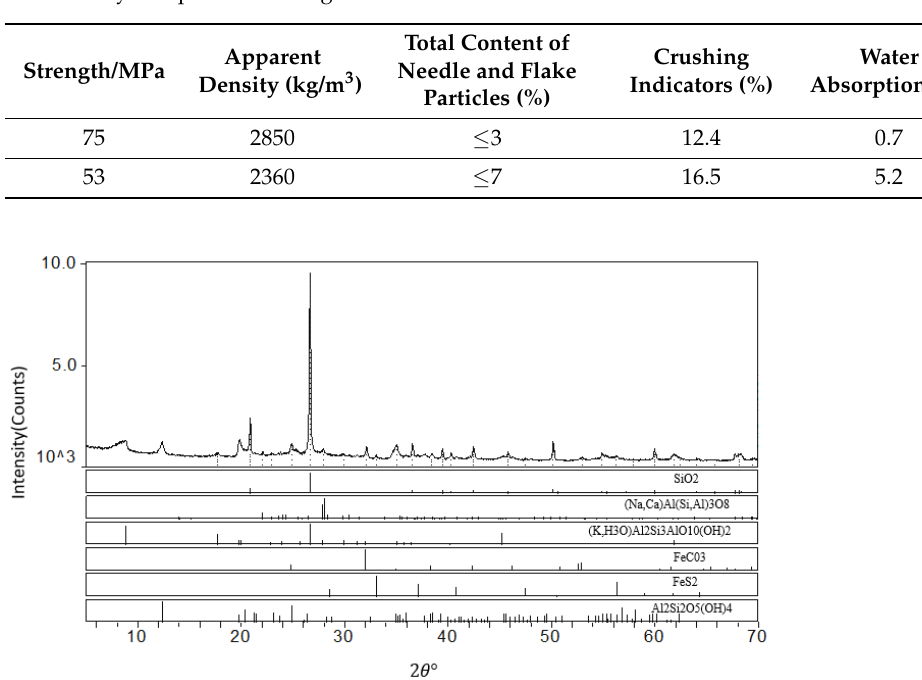
Figure 3. Crushing and screening of gangue. 2.2. Specimen Preparation This paper focuses on the effect of gangue-, fly-ash-, polycarboxylate-superplasti- cizer- and steel-fiber-admixture rate on the slump expansion, 28 d mechanical properties and abrasion resistance of concrete, and it also tries to determine the optimum mix ratio. Most scholars [10,27,28] set the range of fly-ash dosing between 10–40% of the amount of cementitious material, polycarboxylate superplasticizer between 0.5–1.5% of the amount of cementitious material, and steel-fiber dosing less than 2% of the weight of concrete. There is no specific range for setting the amount of gangue, but its performance is better under the conditions of less than 40% of the weight of coarse aggregate. This study is based on other scholars’ studies and determined more accurate optimal dosing ranges for each factor, especially the optimal dosing rate of gangue. It set the amount of the fly-ash admixture in the cementitious material at 20%, 25% and 30%, the amount of gangue ad- mixture in the total amount of coarse aggregate at 20%, 30% and 40%, the amount of pol- ycarboxylate-superplasticizer admixture in the powder material at 0.5%, 1% and 1.5%, and the amount of steel-fiber admixture at 0.5%, 1% and 1.5% of the total weight of con- crete. According to the standards GB/T50080-2016 Standard for Test Method of Perfor- mance on Ordinary Fresh Concrete [29] and 283-2012 Technical Regulations for the Ap- plication of Self-compacting Concrete [30], a four-factor, three-level orthogonal experi- mental design was developed using the orthogonal experimental method. Mark the levels of each factor as K1, K2 and K3, and the mean value of each factor levels as k (cid:2869) ,(cid:3364)(cid:3364)(cid:3364)(cid:3364) k (cid:2870) (cid:3364)(cid:3364)(cid:3364)and k (cid:2871) (cid:3364)(cid:3364)(cid:3364) . The range result is marked as R and the standard deviation result is marked as σ . In order to facilitate the comparative effect analysis, a group of ordinary concretes without gangue,